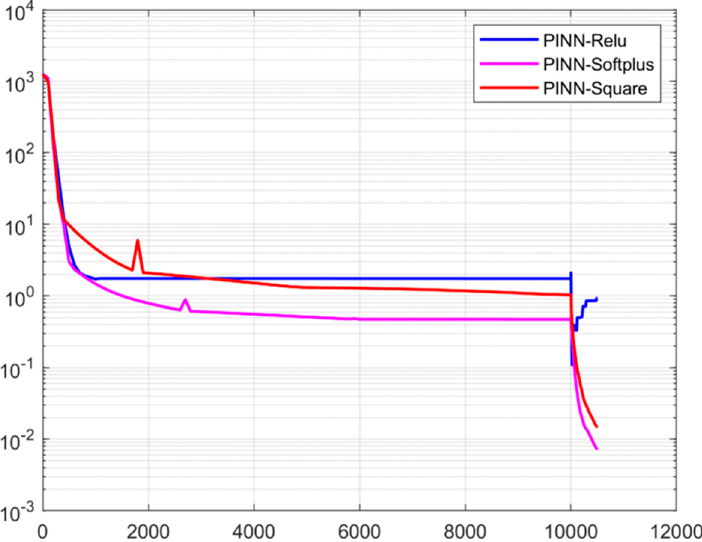
Figure 6. Loss history of the three PINN models that are positivity-preserving .